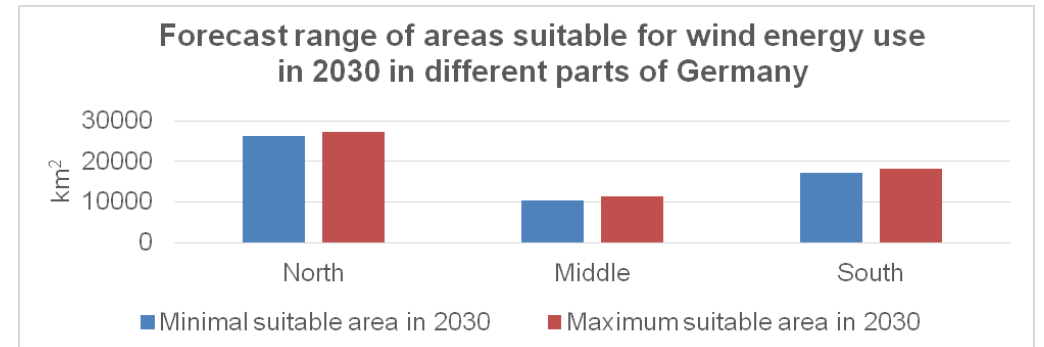
Figure 10. Forecast range of areas suitable for wind energy use in 2030 in different parts of